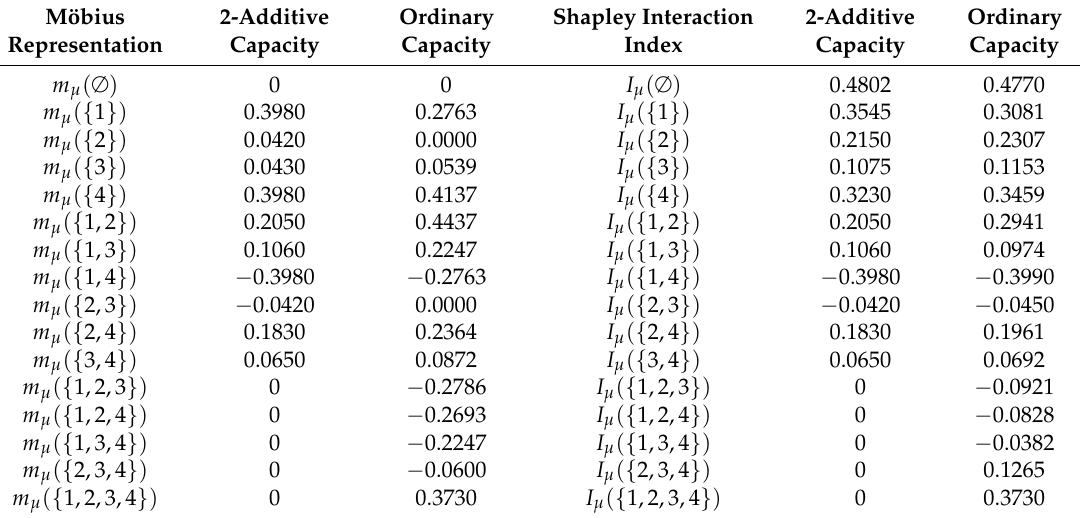
Table 3. The interaction indices of the optimal